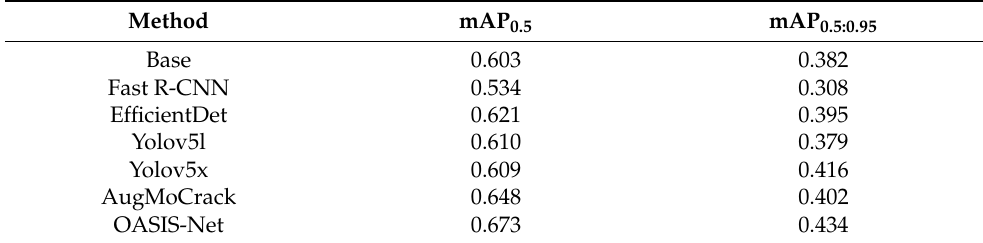
Table 1. Comparison of the mean average precision (mAP) for crack